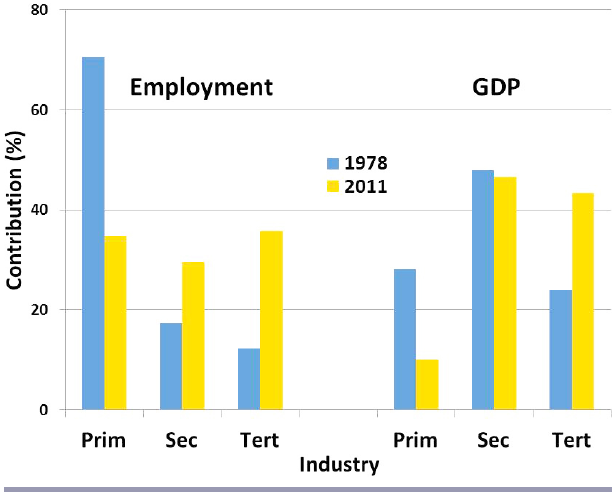
Fig. 1 . Contribution to employment and GDP of primary, secondary, and tertiary industries in 1978 and 2011. The National Bureau of Statistics of China follows the International Standard Industrial Classification of all Economic Activities published by the UN Statistics Division (UNSTAT 2008). Primary refers to agriculture, forestry, animal husbandry, and fishery industries. Secondary refers to mining and quarrying, manufacturing, production and supply of electricity, water and gas, and construction industries. Tertiary refers to all other economic activities not included in the primary or secondary industries (see UNSTAT 2008 and National Bureau of Statistics of China for detailed descriptions). Source: based on China Statistical Yearbook (National Bureau of Statistics of China (several